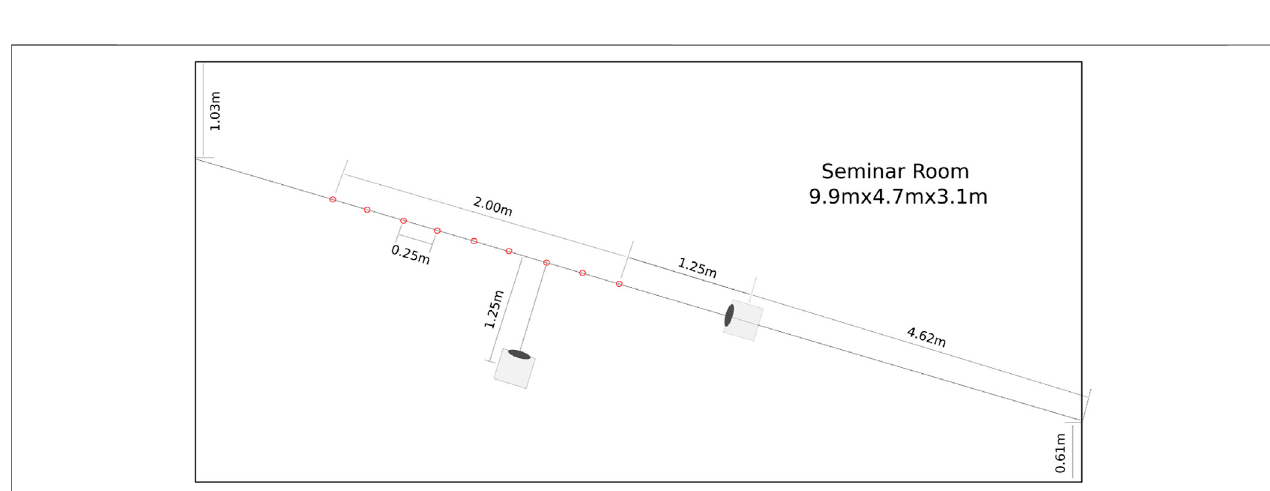
FIGURE2| SetupfortheBRIRmeasurementinthechosenseminarroom.AKGK1000headphoneswereplacedontheKemar45BA ’ searsthroughoutthemeasurement.